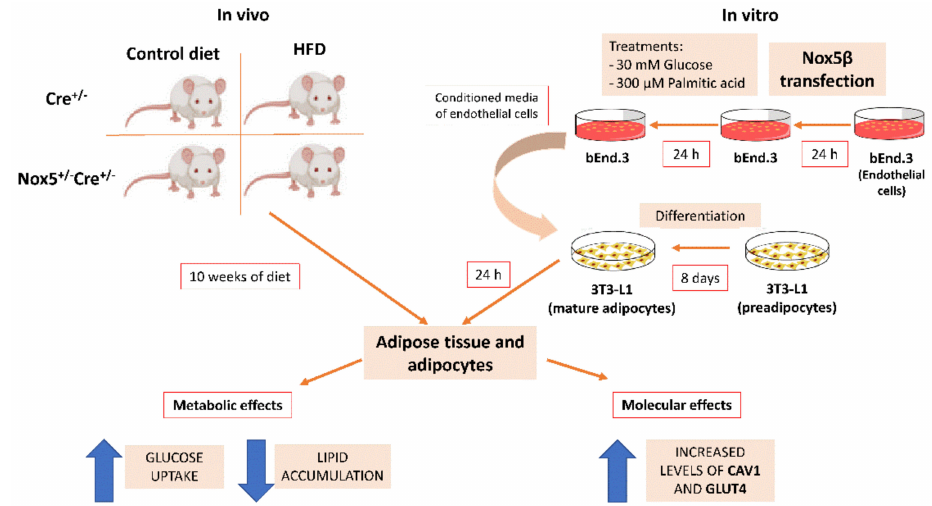
Figure 8. Graphical scheme of the experimental design and principal